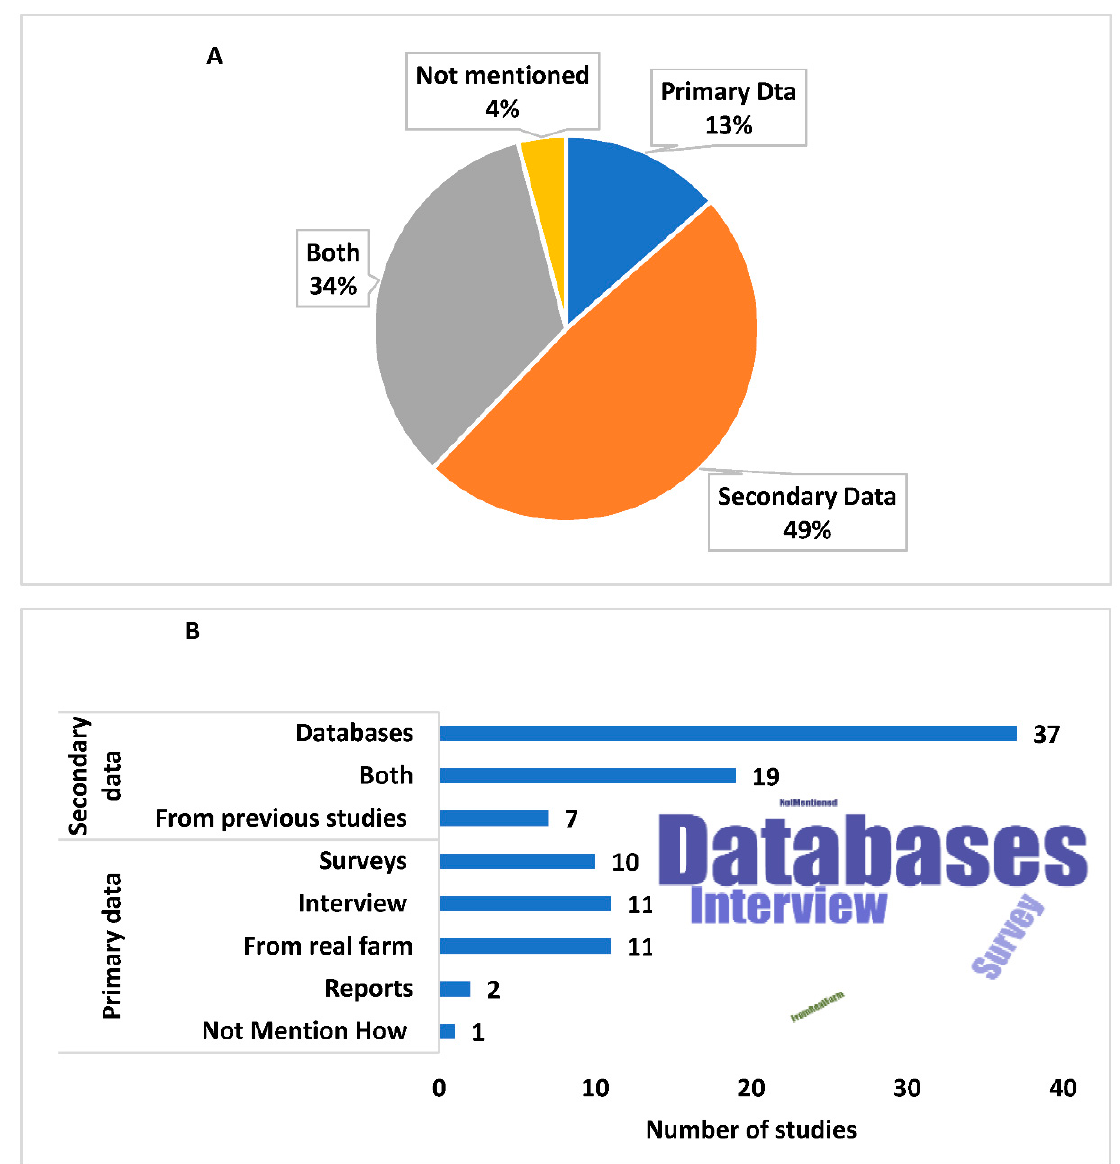
Figure 12. ( A ) Data sources of the inventory stage rendered as a pie chart; ( B ) breakdown of primary and secondary data into various sources as obtained from the studies.